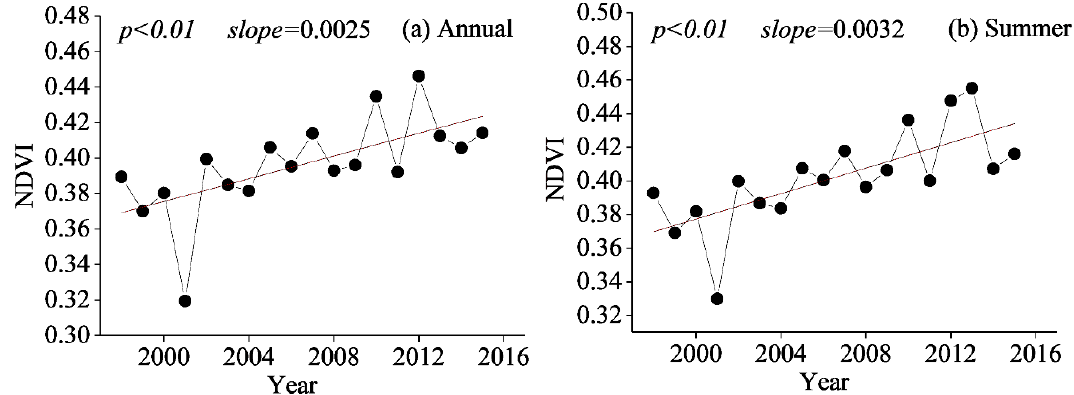
Figure 10. The change trend of the annual and summer (June-July-August) NDVI in the upper (UHRB) and middle (MHRB) reaches of the Heihe River Basin 1998–2015.